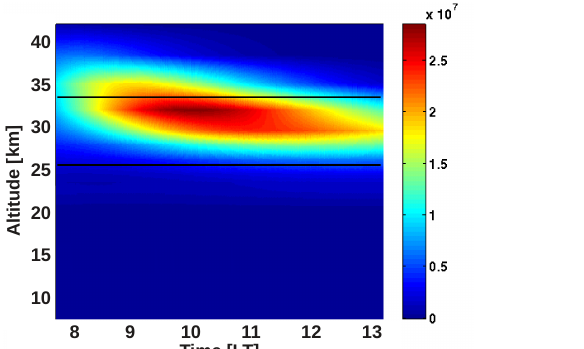
s s 1 (left panel) and 2 (right panel) on the absorption